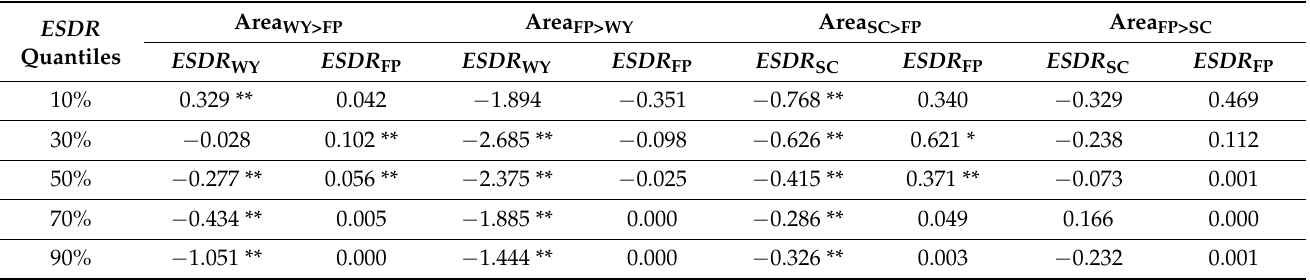
Table 3. Quantile regression between the trade-offs intensities and supply–demand